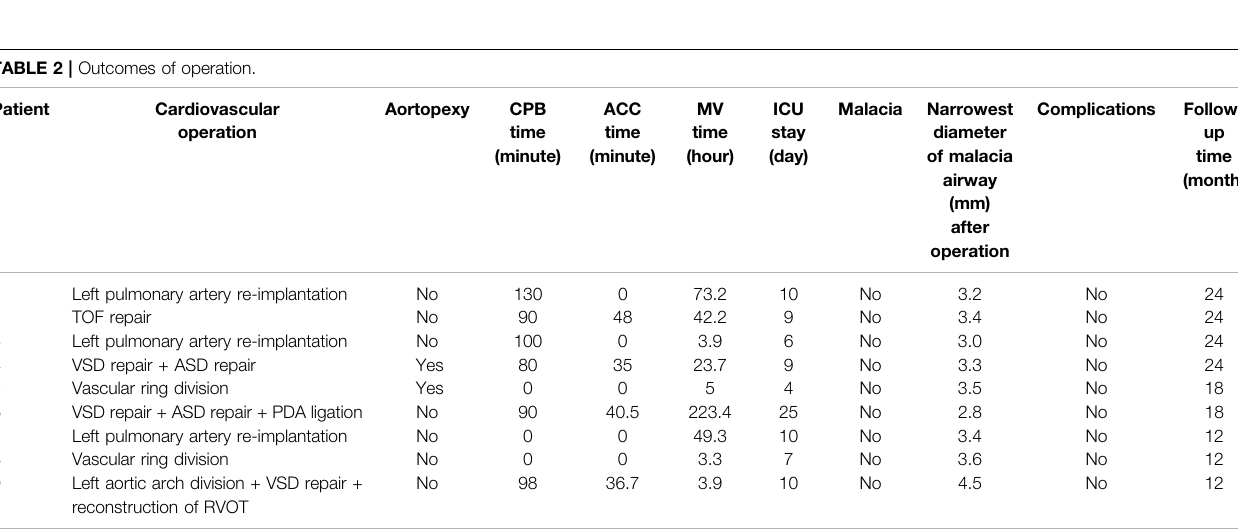
TABLE 2 | Outcomes of